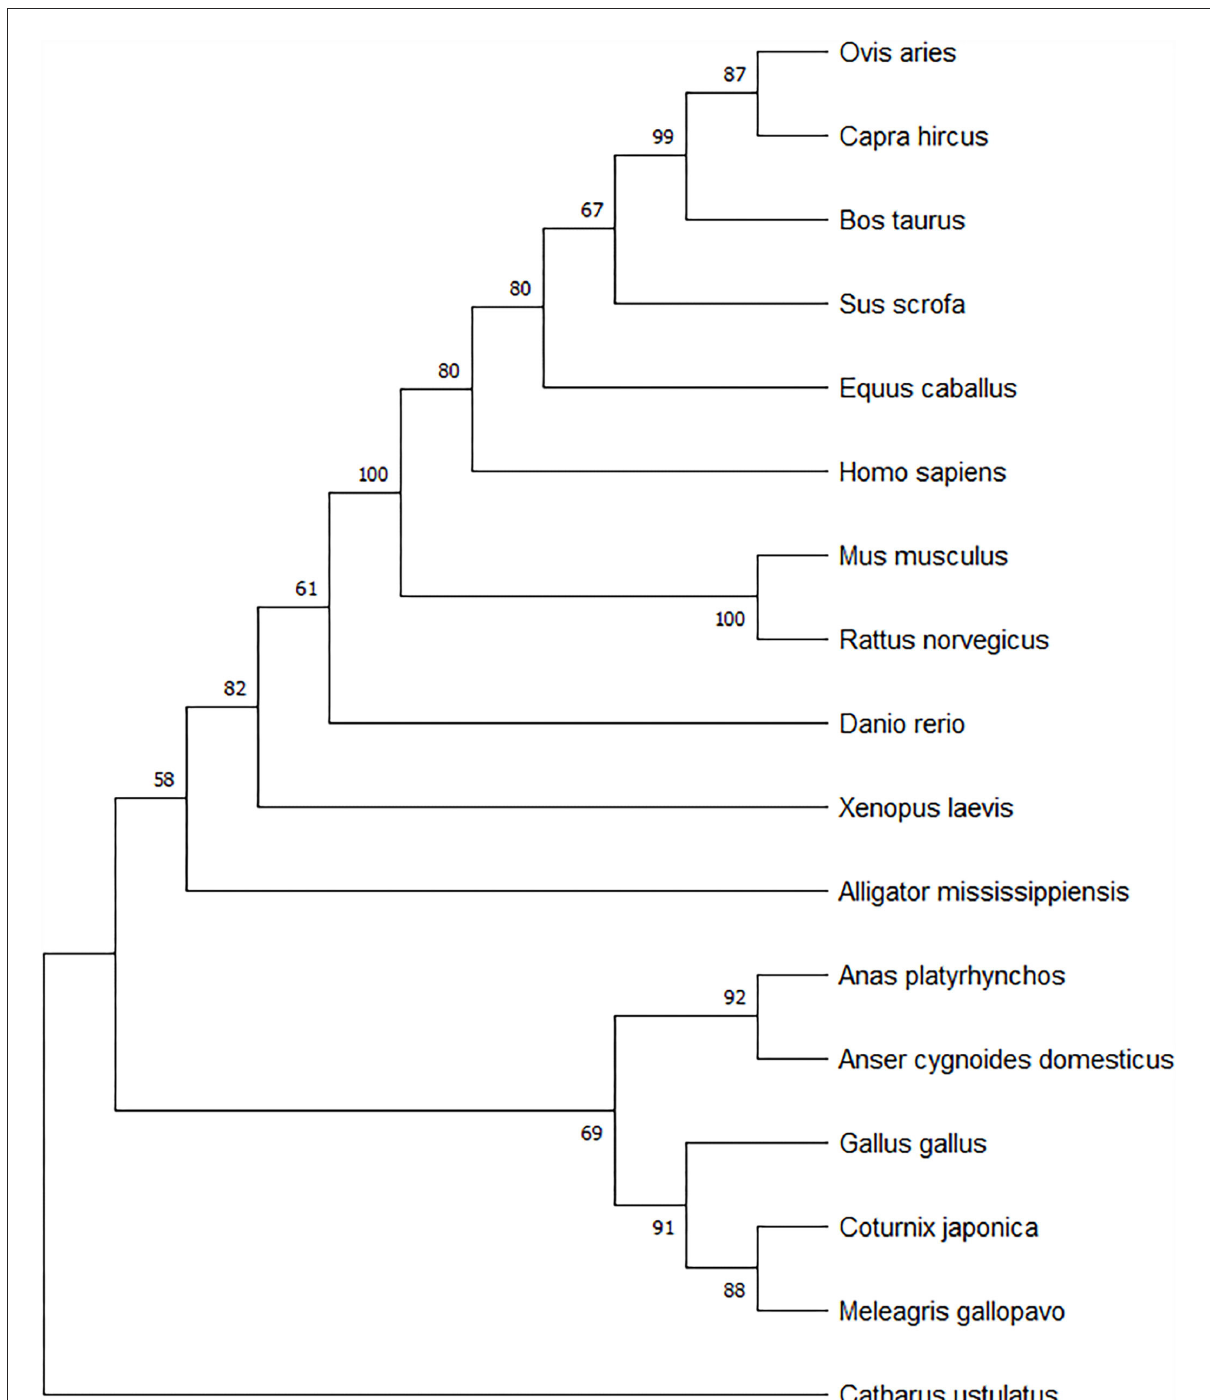
FIGURE2 Spexin phylogenetic tree based on Neighbor-Joining method using MEGA5. The branch length scale in terms of genetic distance is indicated above the